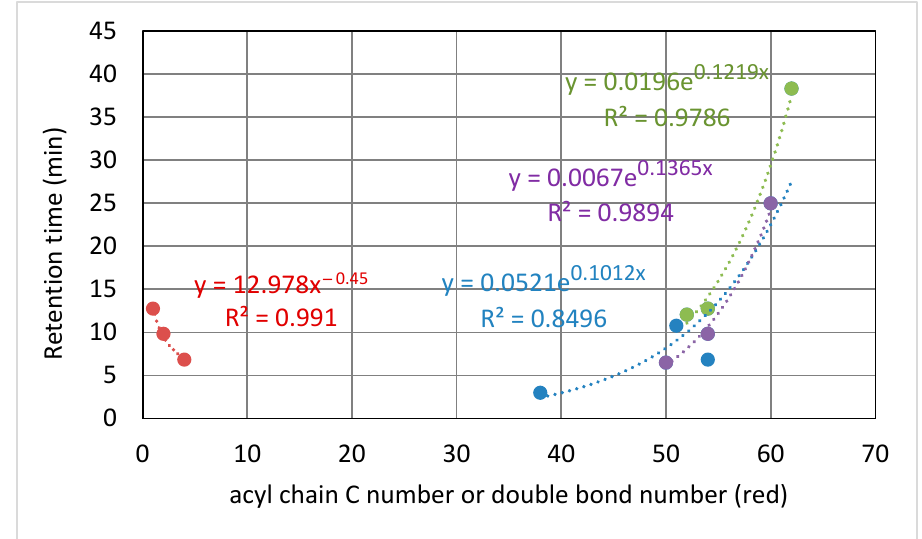
Figure 3. Elution time with the carbon number of the acyl chains for the same number of unsatura- tions (green, one double bond; violet, two double bonds; and blue, merged C number irrespective of the double bonds) and with the double bond number for 54 acyl carbons (red). Data for [NH 4 OH] = 9.13 mM.